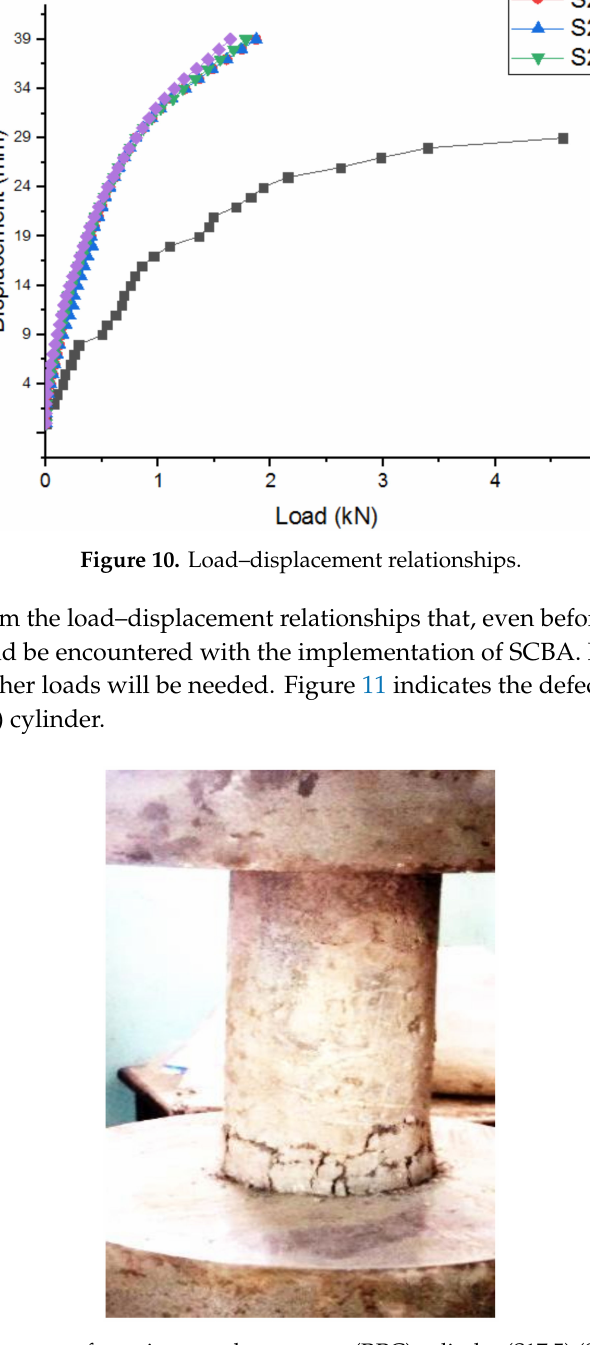
Figure 11. Failure pattern of reactive powder concrete (RPC) cylinder (S17.5) (Scale: